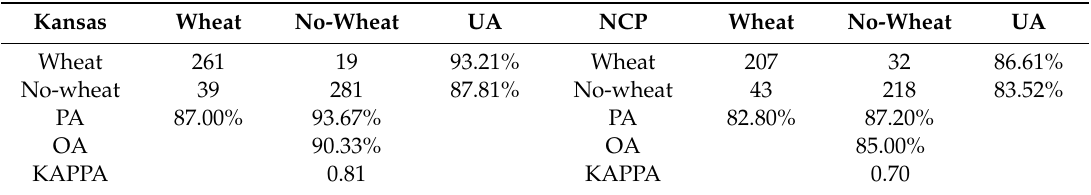
Table 9. Confusion matrix for Kansas and the NCP 1 .